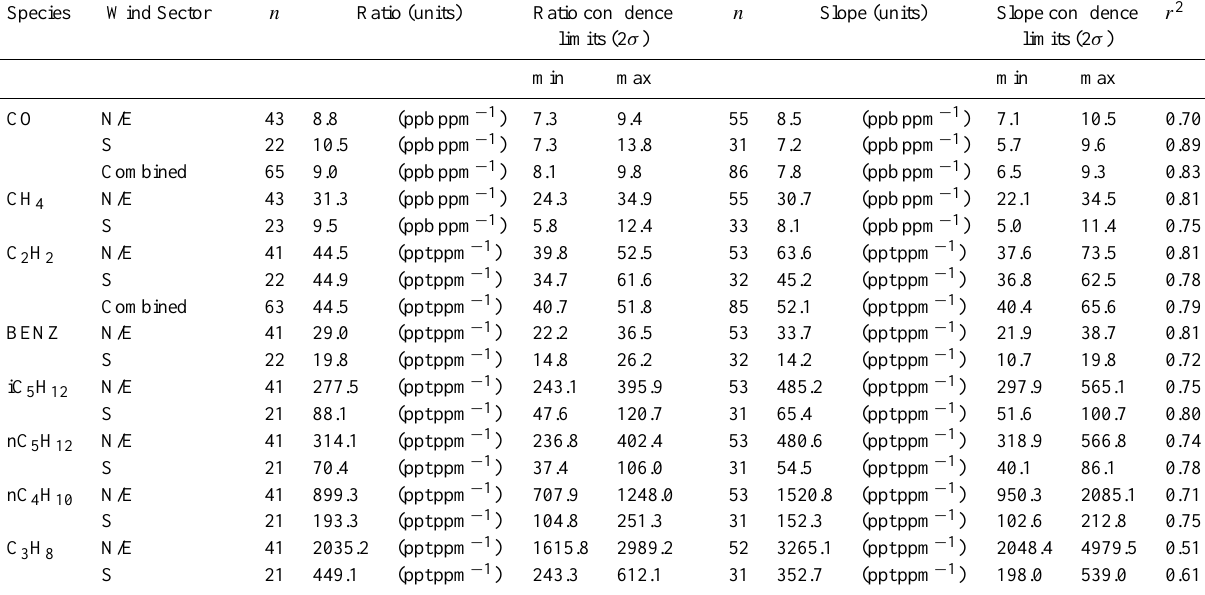
Table 1. Summary of observed tracer/CO 2 ff ratios and associated uncertainties. Ratios estimated using the median point-by-point calculation as well as from a two way linear regression. Correlation coefficients ( r 2 ) are also provided. For the C 4 and C 5 alkanes, C 2 H 2 , and benzene, a nonlinearity bias in the GC-MS response results in an estimated 5–12% overestimate in the tracer/CO 2 ff ratios for these gases.